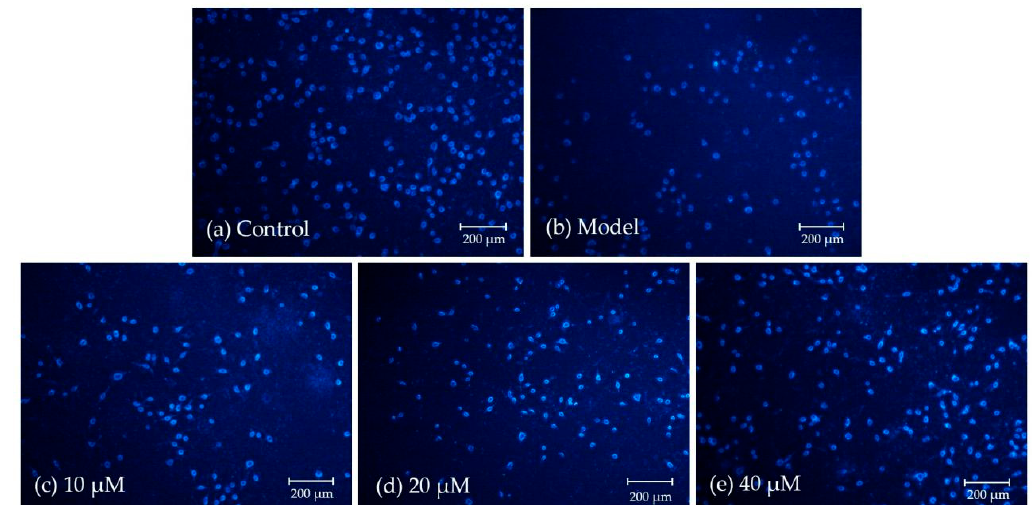
Figure 3. DAP staining on SH-SY5Y cells treated with compound DG-15 with different concentrations: ( a ) Control group; ( b ) TBHP treated cells; ( c ) 10 μ M; ( d ) 20 μ M; ( e ) 40 μ M. The cell morphology was observed under the fluorescence microscope. The most representative fields were shown. Calibration bar: 200 μ m.